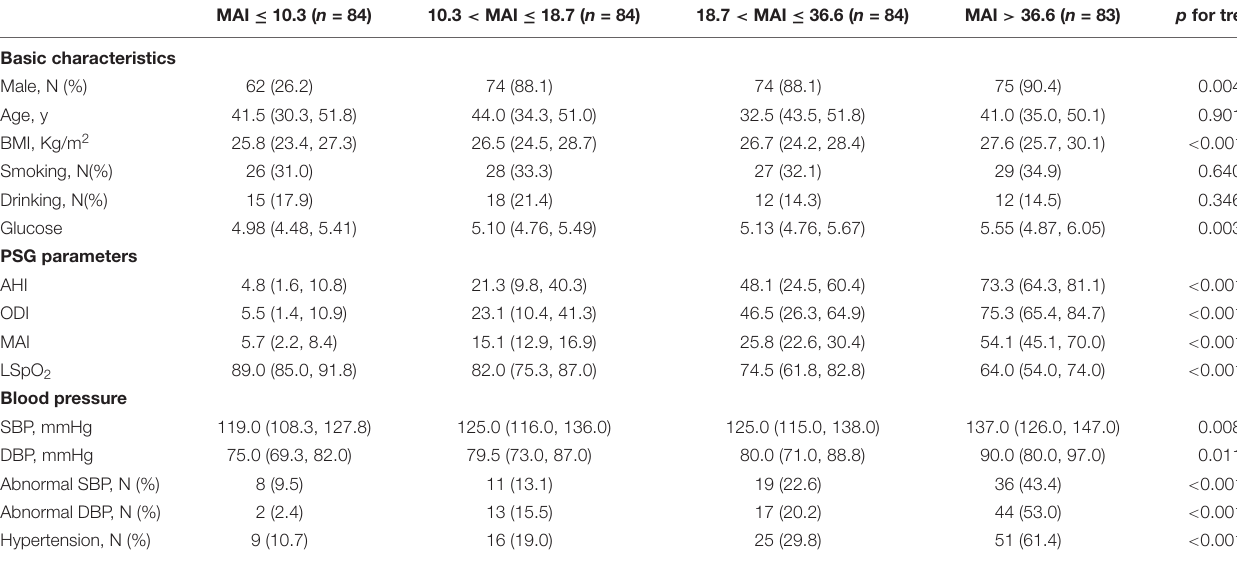
TABLE 2 | Characteristics and blood pressure of included subjects according to MAI quartiles.